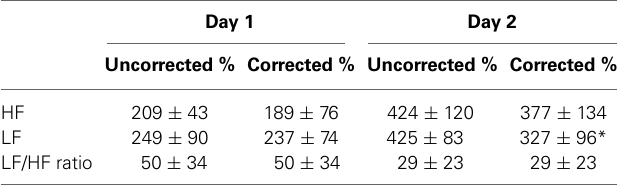
Table 2 | Percent changes in HRV parameters following Day 0 (defervescence) with and without HR